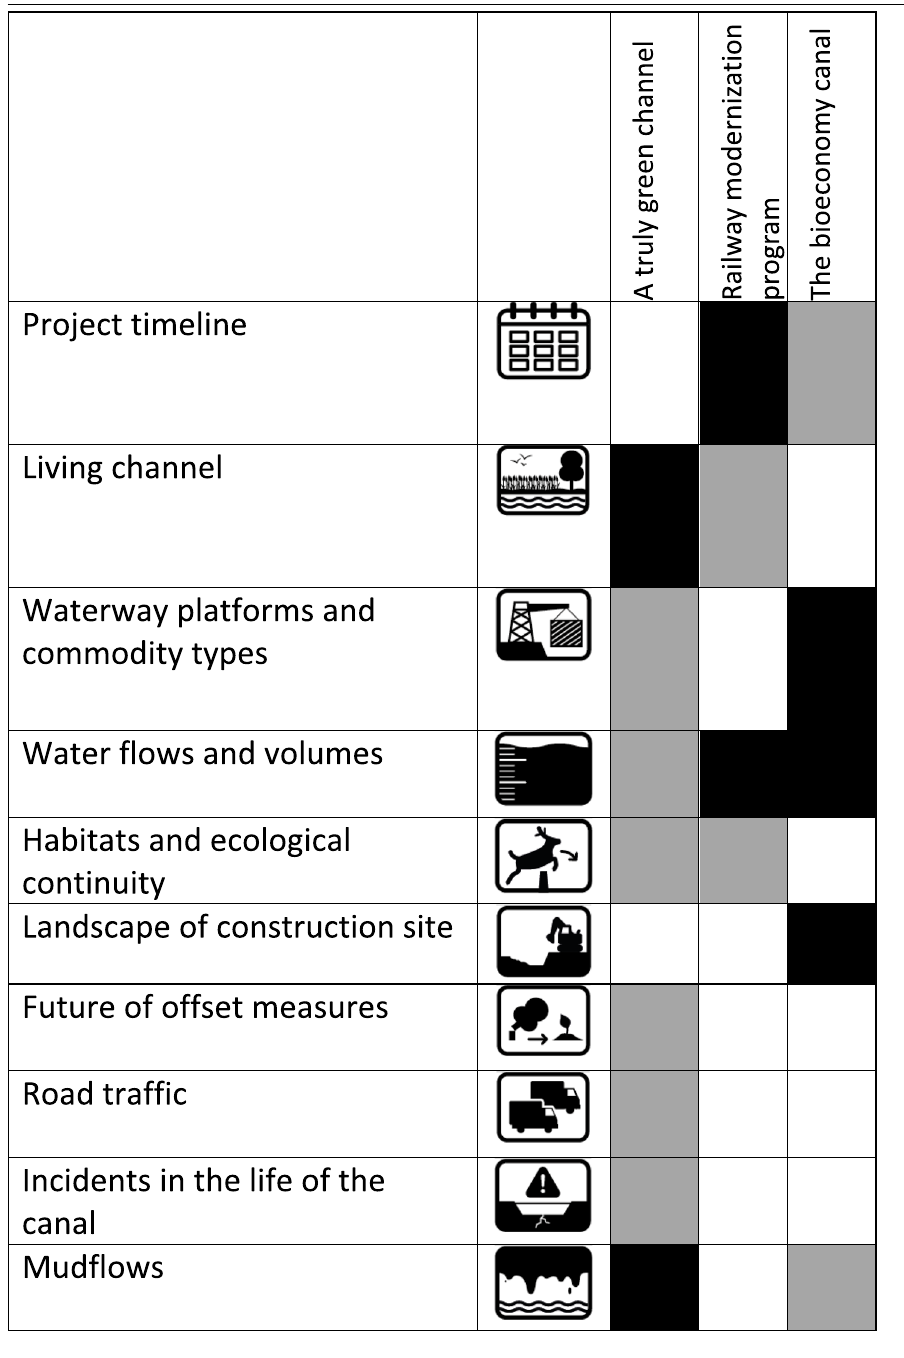
Table 1 In the 3 imagined scenarios, 10 motives were taken into account as hot, managed, or silent issues. Their graphical representations are used in the following figures in black, grey or pale grey according to their salience in the